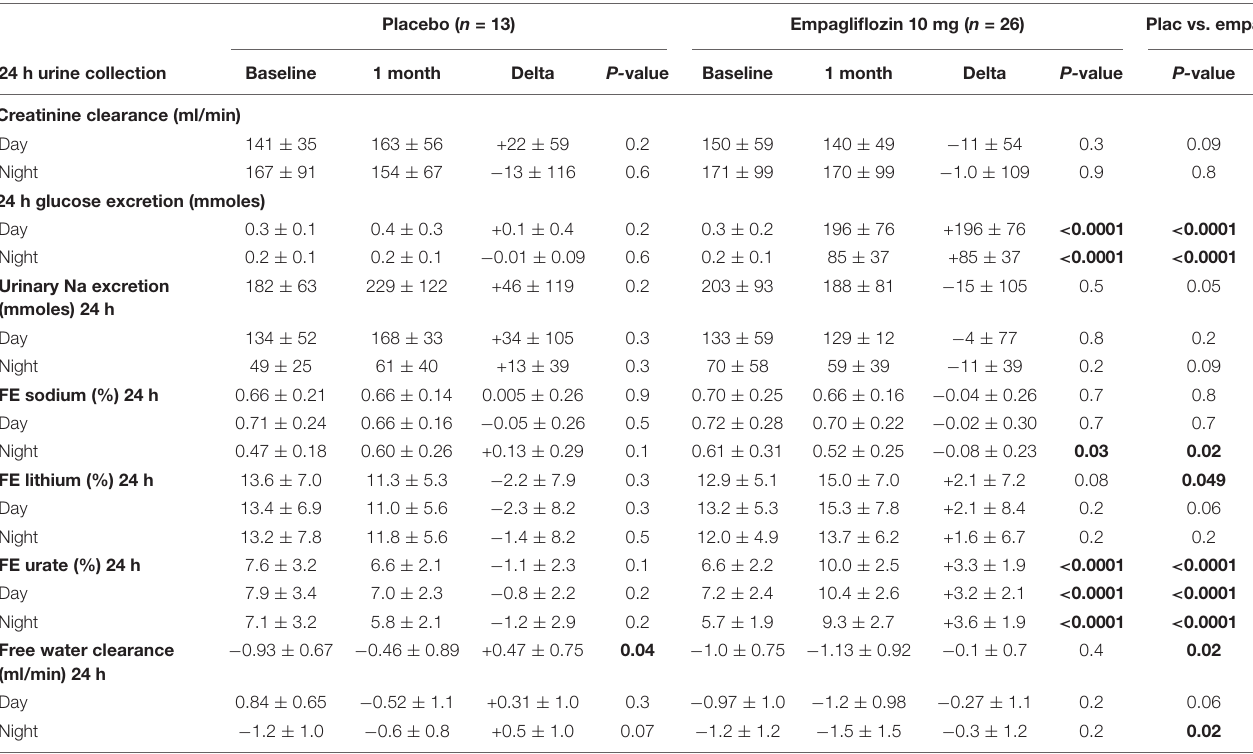
TABLE 3 | Creatinine clearance, Urinary glucose, sodium, lithium, water, and uric acid excretion measured at baseline and after 1 month of empagliflozin 10 mg. Placebo ( n = 13) Empagliflozin 10 mg ( n = 26) Plac vs.